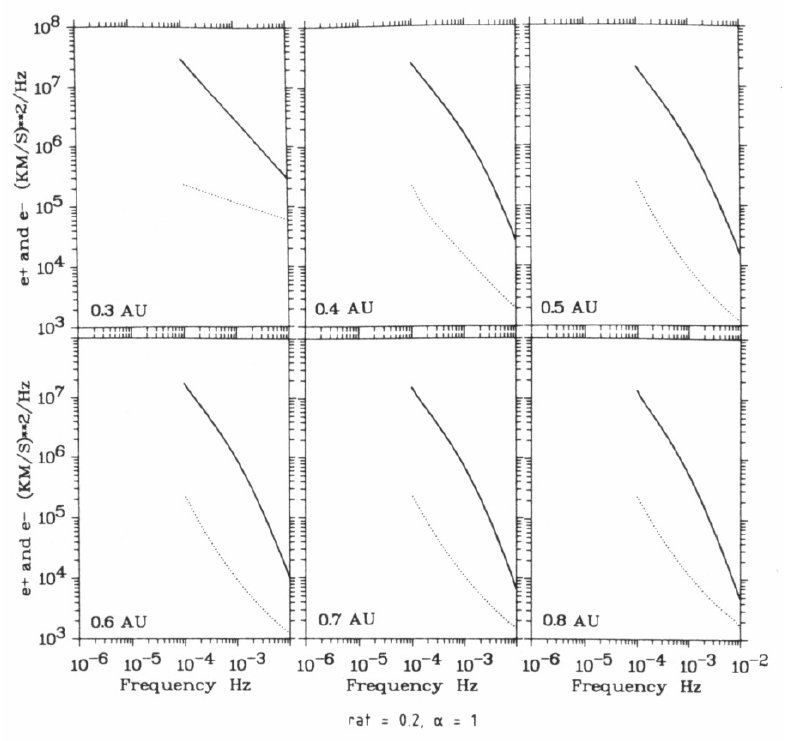
Figure 68: Radial evolution of e + and e – spectra obtained from the Marsch and Tu (1993a) model, in which a parametric decay source term was added to the Tu’s model (Tu et al. , 1984) that was, in turn, extended by including both spectrum equations for e + and e – and solved them self-consistently. Image reproduced by permission from Marsch and Tu (1993a), copyright by